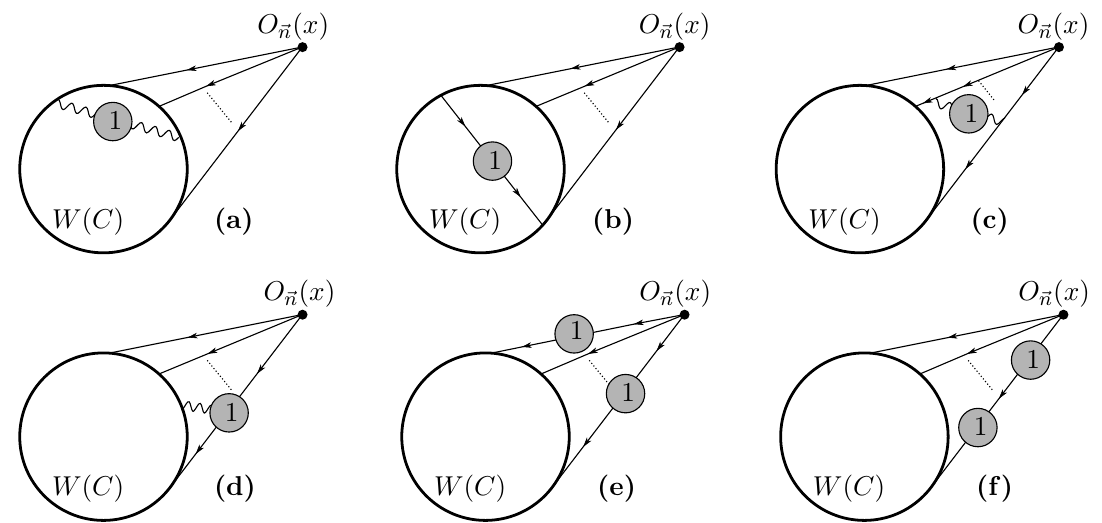
Figure 6 . Some examples of diagrams contributing to (cid:14)A ~n at two loops. Diagrams ( a ) and ( c ) contain the one-loop correction of the gluon propagator, diagram ( d ) contains the one-loop correction to the 3-point vertex, while diagrams ( b ), ( e ) and ( f ) contain the one-loop correction to the scalar propagator. All these diagrams vanish in the superconformal theory since they are proportional to ( N f (cid:0) 2 N ). Beside these, one should also consider the one-loop diagrams of (cid:12)gure 3 in which one of the external scalar propagators is corrected at one loop. Also such diagrams vanish in the superconformal theory.